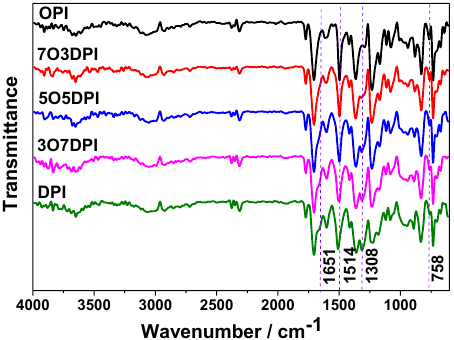
Figure 2. Fourier transform infrared (FT-IR) spectra of the polyimide films. OPI refers to a polyimide film where ODA:DABA = 10:0; 7O3DPI a film where ODA:DABA = 7:3; 5O5DPI a film